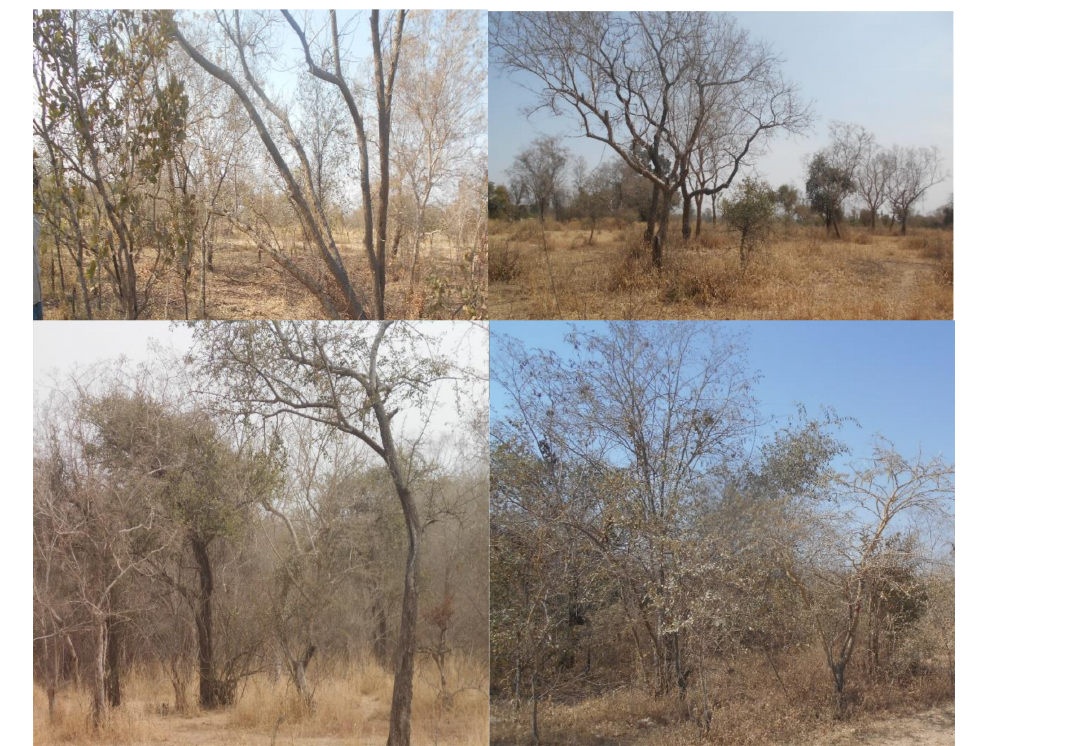
Figure 2. From left to right clockwise: low-density shrub savannah (Laf), herbaceous savannah (Zamai), moderately densified shrub savannah (Kosohon) and wooded savannah (Mozogo).